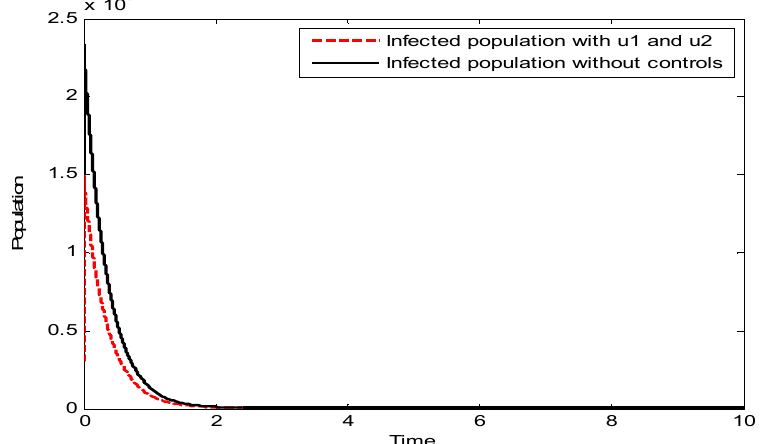
Figure 6. Comparing the dynamics of the infected population without control and with control u 1 & u 2 .